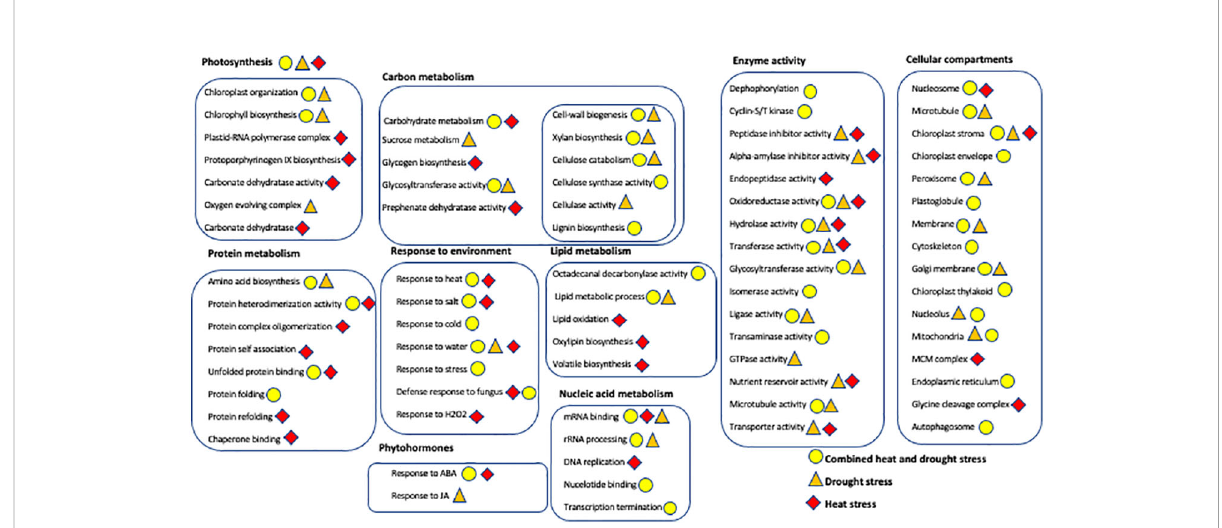
FIGURE 7 Overview of the Gene Ontology enrichment analysis showing the major biological processes, molecular functions, and cellular compartments of differentially expressed genes from leaves and head of Golden Promise and Otis in response to drought (brown triangles), heat (red diamond) and combined stress (yellow circle). Metabolic processes, molecular functions and genes encoding for proteins with speci fi c activities are grouped within boxes. Only statistically signi fi cant GOs (P-value <0.001 and FDR<0.05) and those containing three or more DEGs were used for creating this